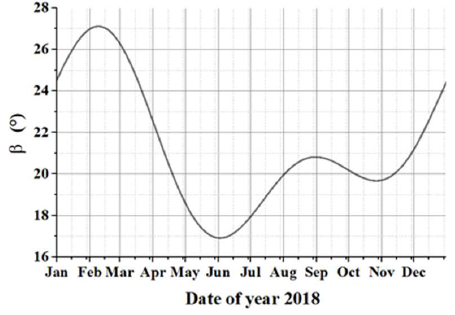
Figure 10. The changes of the angle between the solar vector and orbital plane changes in one year. Angle is smallest on June 3rd of each year, therefore, the relative position of the satellite and the sun is analyzed on this day to obtain the minimum angle between the sun vector and the camera axis. As the satellite has the ability to observe the earth with a swing angle of ± 30 ◦ , we analysis three different kinds of conditions: without swing, rolling right 30 ◦ and rolling left 30 ◦ and results are shown as Figure 11. The minimum angle between solar vector and the camera optical axis is 52 ◦ .